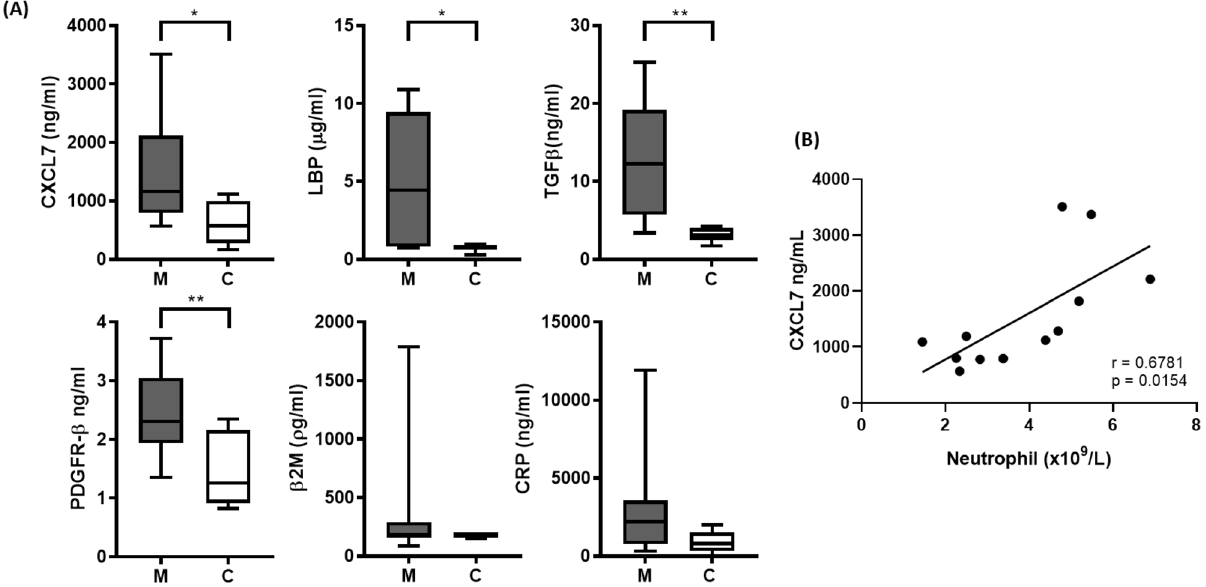
Figure 5. Circulating plasma levels of key hub immune proteins in mastocytosis patients. ( a ) Plasma protein measurements were compared between systemic mastocytosis patients (n = 12) and healthy controls (n = 8), the box and whisker plots show the upper and lower quartile protein concentration, the median concentration is indicated by a horizontal line. Significance was determined using the Student’s T-Test, p < 0.05 was considered statistically significant (*p< 0.05, **< 0.01). ( b ) CXCL7 plasma levels correlate to neutrophil numbers (r = 0.6781, p =